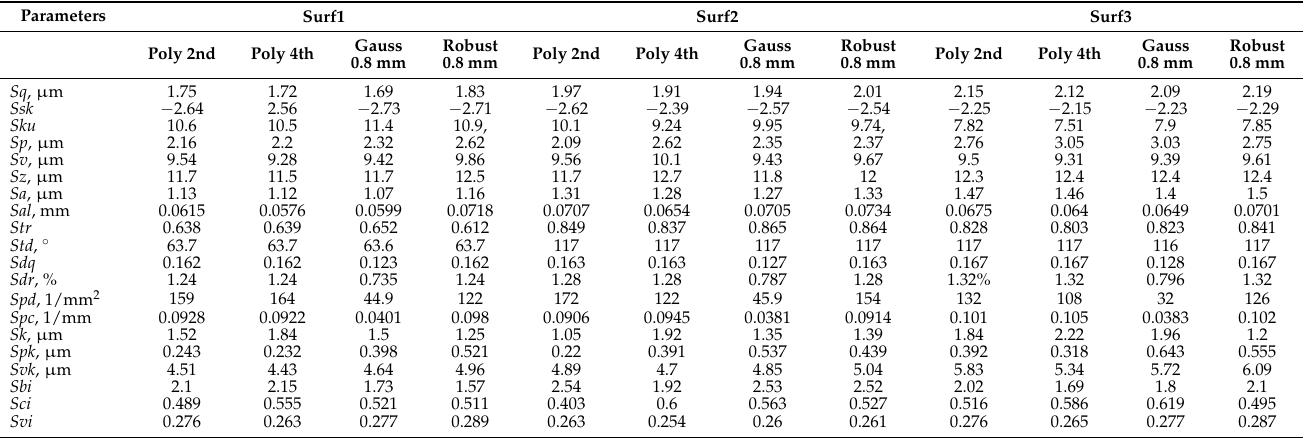
Table 1. Surface topography parameters calculated for plateau-honed cylinder liner surfaces with different densities (numbers) of oil pockets and after form removal by various techniques. Parameters